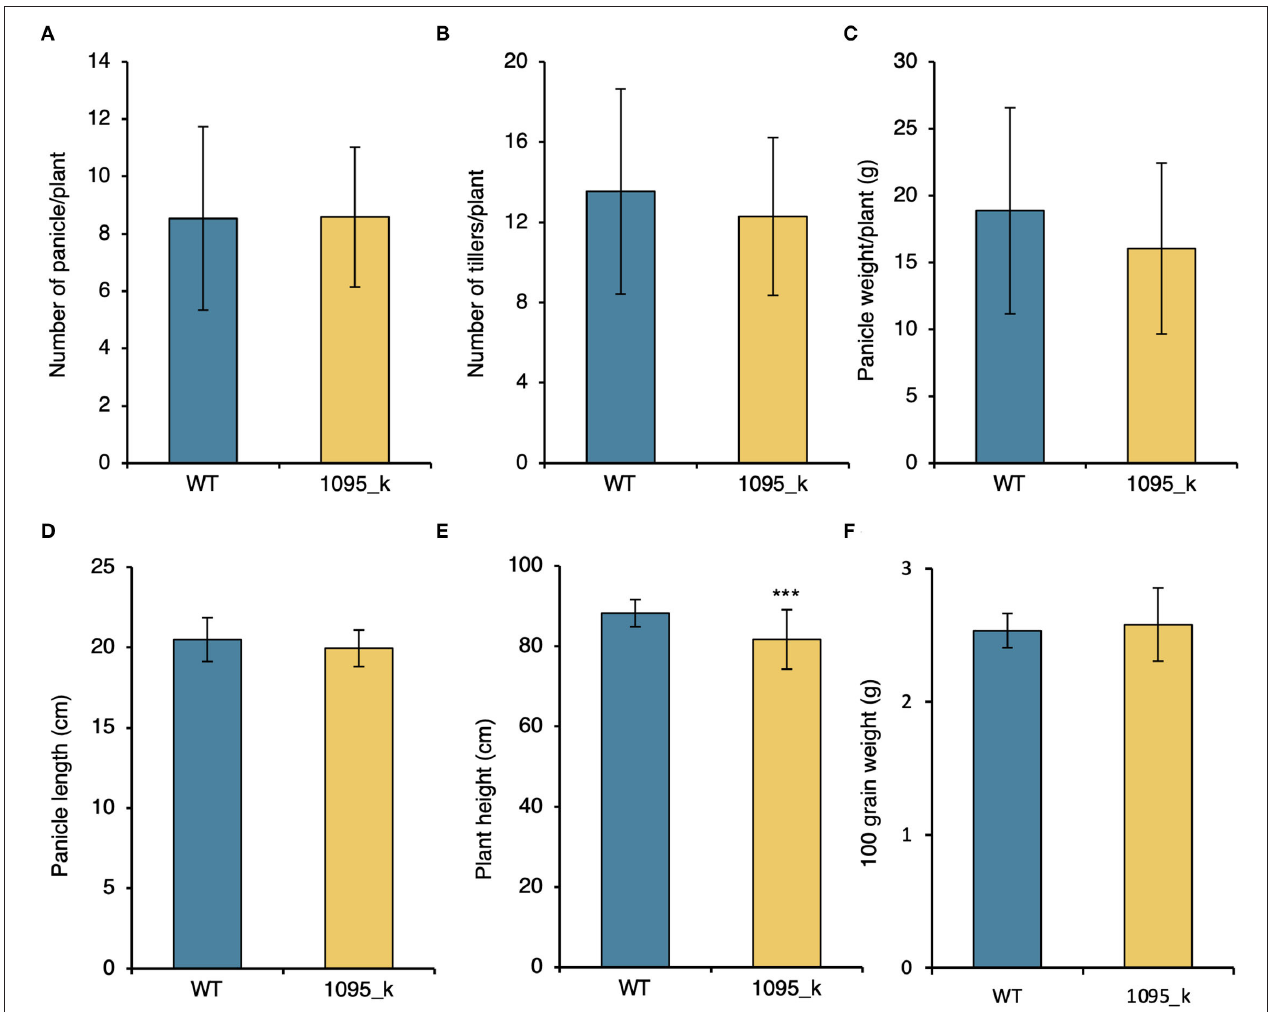
FIGURE 2 | Characteristics of the high Fe mutant. (A) Number of panicle/plant, (B) number of tillers/plant, (C) panicle weight/plant, (D) Panicle length, (E) Plant height, and (F) 100 grain weight of WT and 1095_k. Plants were harvested from the paddy field after maturation. Significant difference using Student’s t -test. *** p < 0.001. Error bar = SD. n =